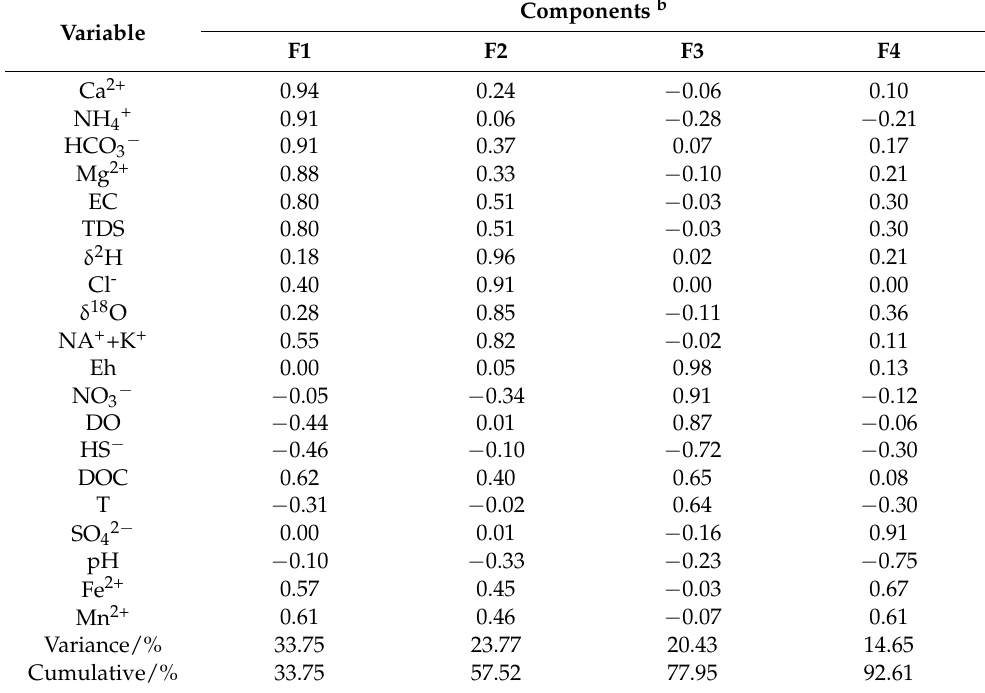
Table 1. Factor analysis for shallow groundwater samples in November (n = 13) a .